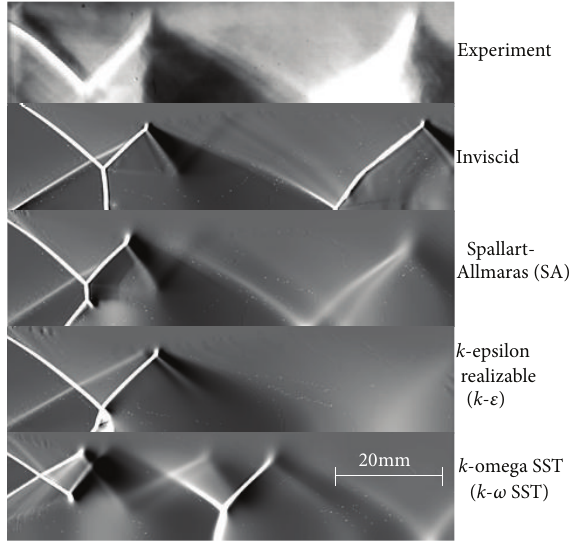
Figure 7: Effect of mesh refinement on the predicted shock struc- ture.